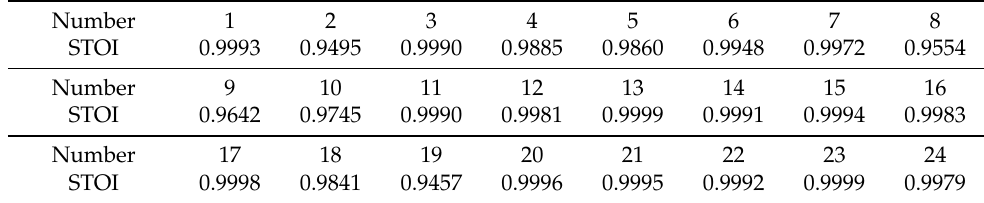
Table 6. The STOI values of the reconstructed secret audios.